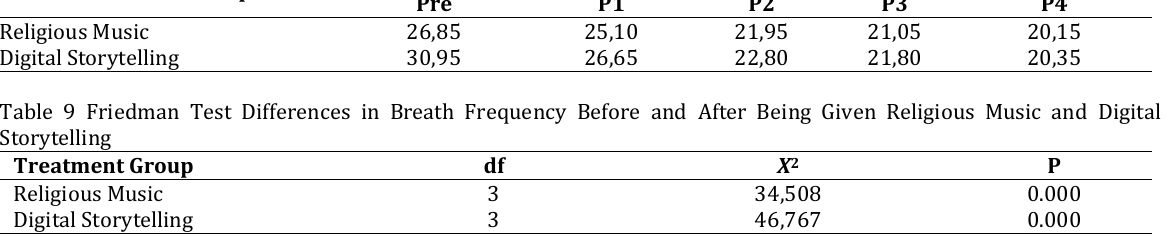
Table 8 The Mean Respiration Rate of Respondents Treatment Group